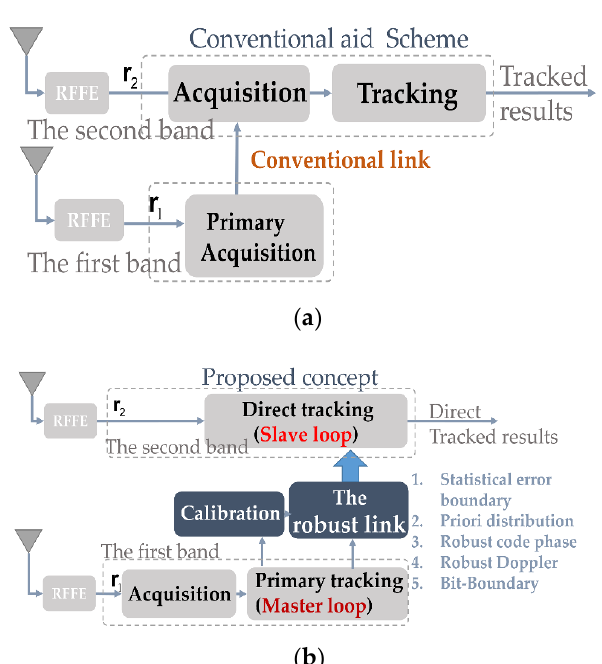
Figure 1. ( a ) Conventional aided acquisition. ( b ) Proposed direct aided tracking scheme and robust